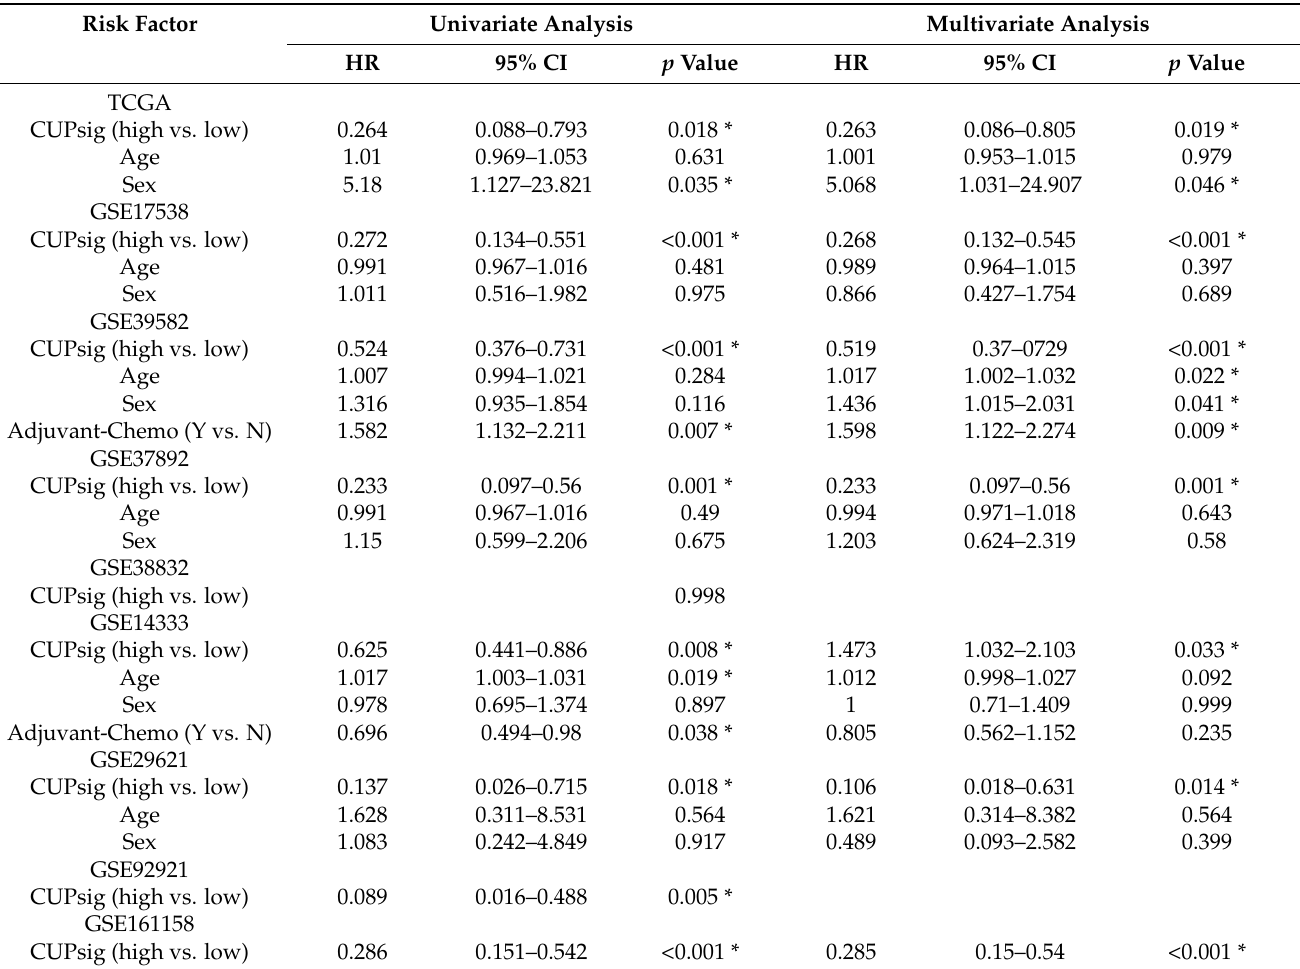
Table 2. Univariate and multivariate Cox regression analysis results of CUPsig in validation datasets. * p <